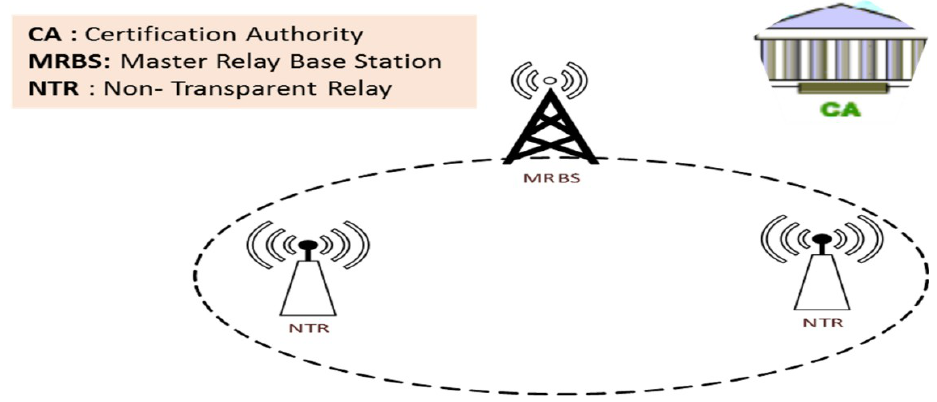
Figure 2. Showing system model diagram for the proposed solution. 151